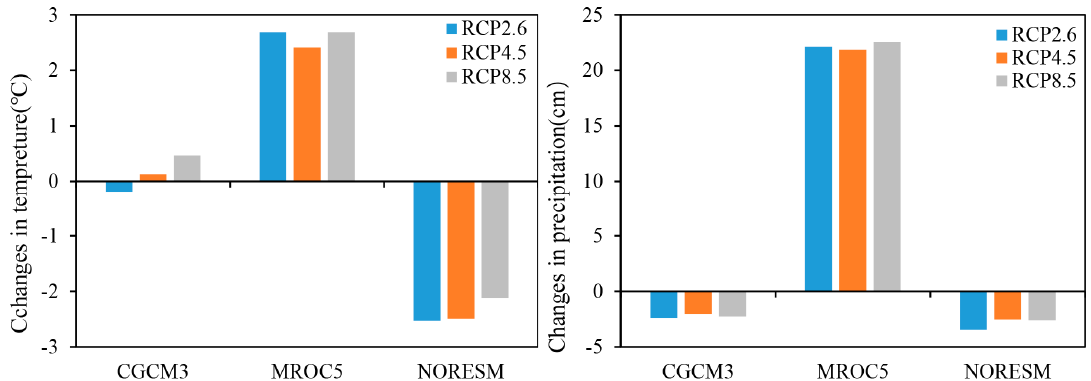
Figure 4. Changes in the temperature and precipitation predicted under different climate scenarios from 2018 to 2047 for the three climate models. RCP, representative concentration pathway.